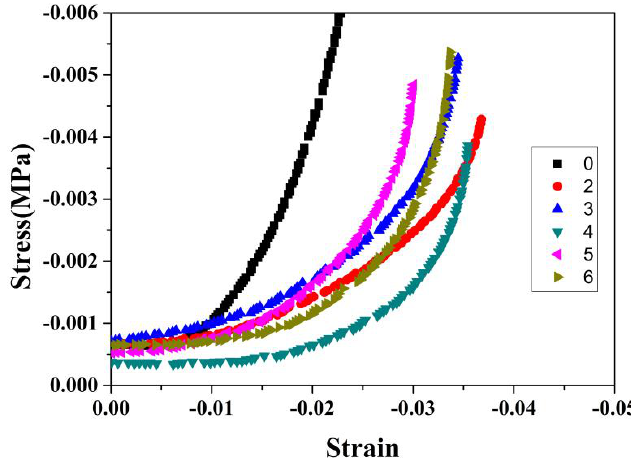
Figure 7. Low strain recovery testing results of the CO 2 -SPD aerogel along with the cycles of thermal shock.